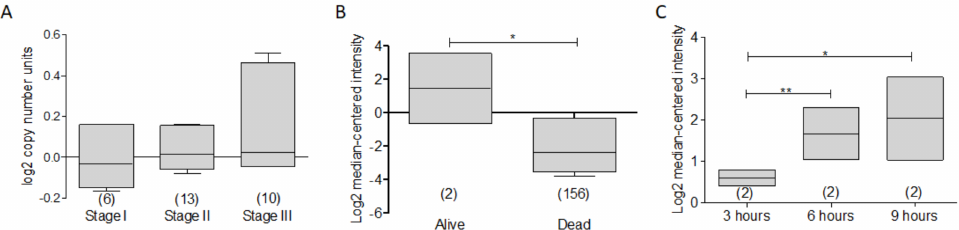
Figure 13. BCL-XL as a potential biomarker in Multiple Myeloma. ( A ) According to the stage of Myeloma, a discrete increase in the expression of BCL-XL is found in advanced stages. ( B ) In the dataset of Mullingan et al. [93], the expression of BCL-xL was higher in alive patients compared to dead (* p < 0.05). ( C ) In Raab et al. [95], there was a significant increase in the expression of BCL-XL in function of time (* p < 0.001, ** p <